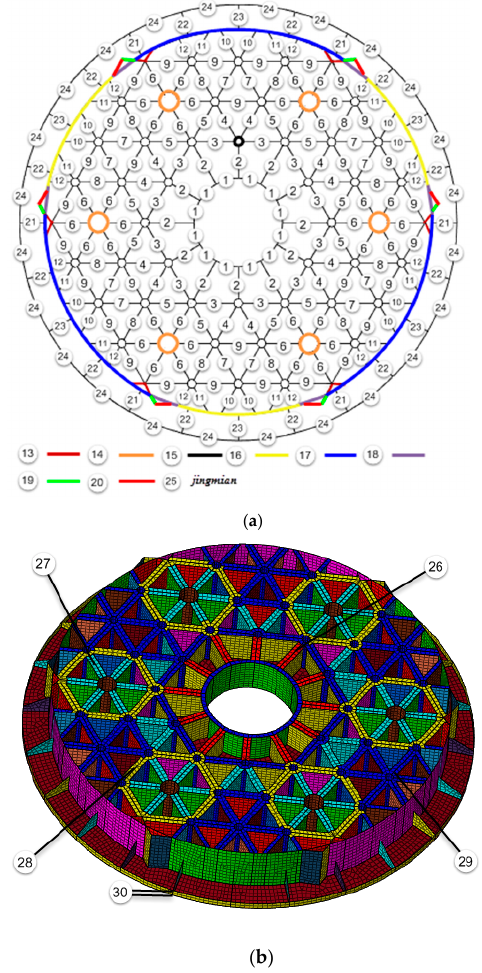
Figure 5. Grouping of primary mirror ribs based on topology optimization. ( a ) the mirror face and each ribs group number ( b ) the back face and edge rib height group number.